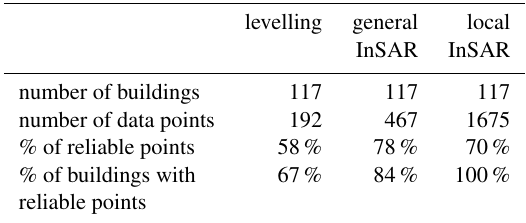
Figure 4. Maps showing the results of the analysis for levelling (a) and two InSAR data sets (b) and (c) . The building footprints have been anonymised.